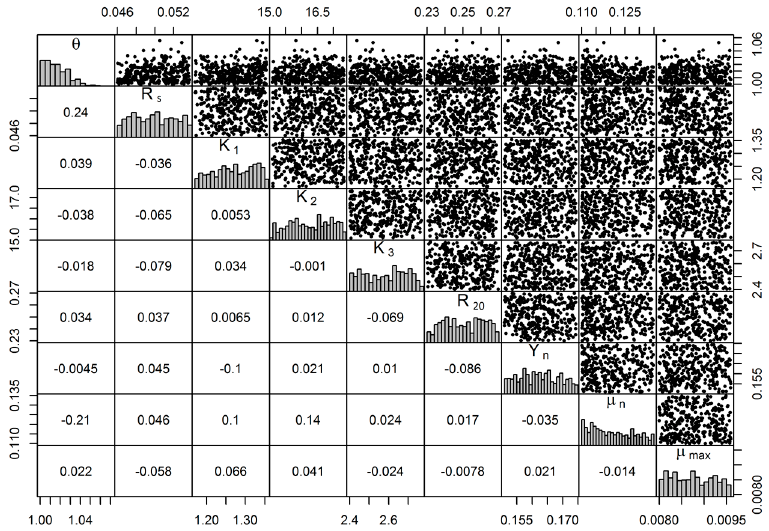
Figure 4. Pairs plot of the Markov chain Monte Carlo (MCMC) samples for the nine parameters. Note: Top is the pairwise relationship; bottom is the correlation coefficient; diagonal is marginal distribution.